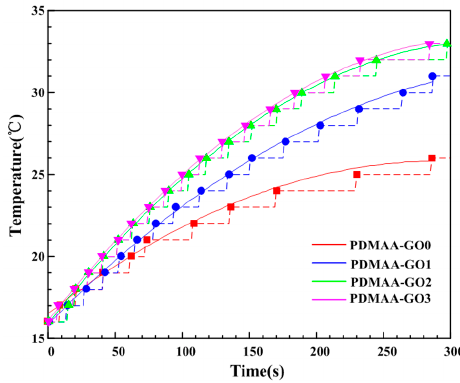
Figure 5. Photothermal energy transformation efficiency of PDMAA hydrogels with various GO contents.